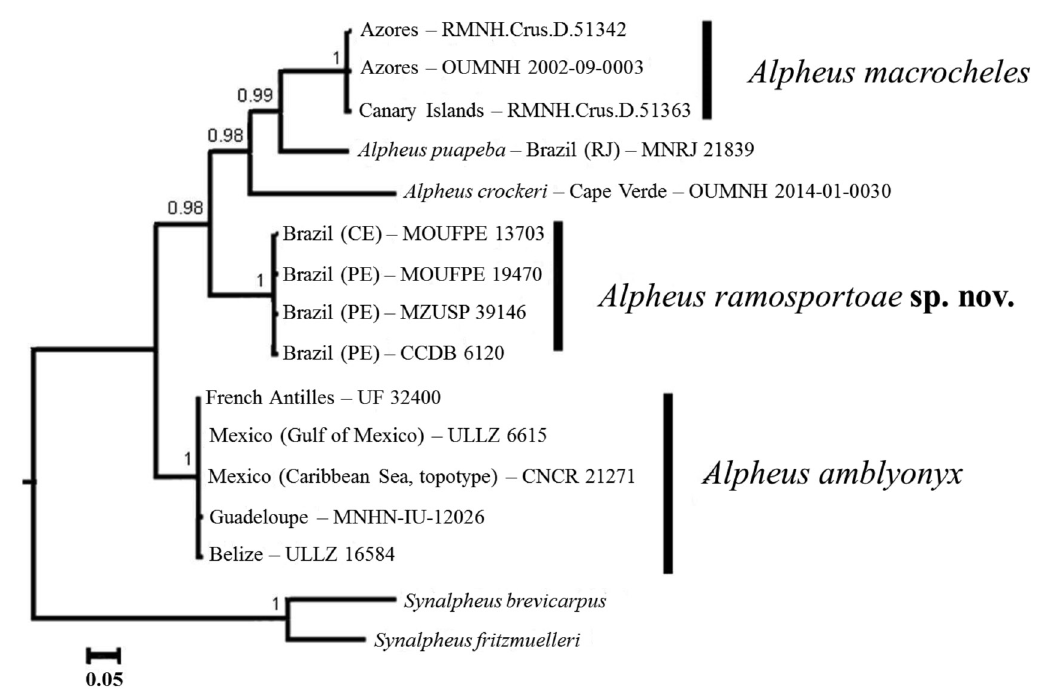
Fig. 5. Bayesian Inference Tree of the 16S gene including specimens of Alpheus ramosportoae sp. nov., selected species of the A. macrocheles complex, and Synalpheus C.S. Bate, 1888. Numbers close to nodes represent posterior probabilities. Abbreviations: CE = state of Ceará; PE = state of